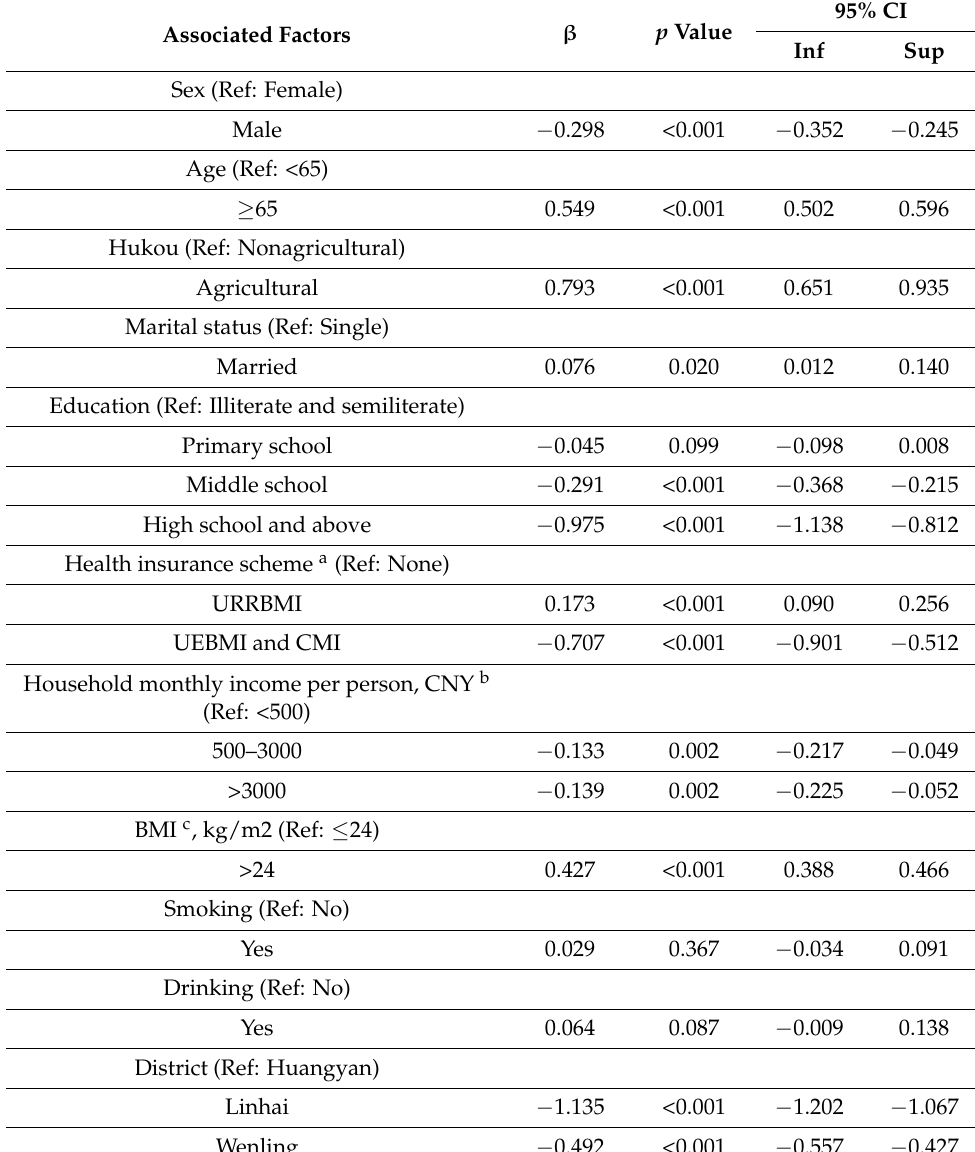
Table 3. Number and proportion of patients with and without free medicine use in